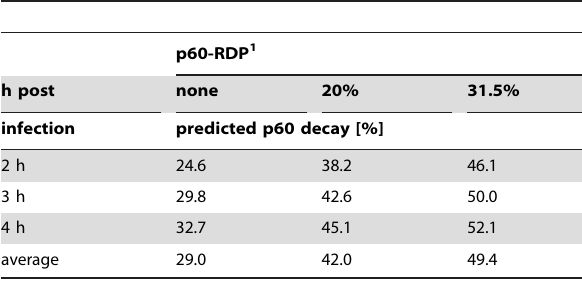
Table 1. Predicted p60 decay in the presence and absence of p60-RDP.